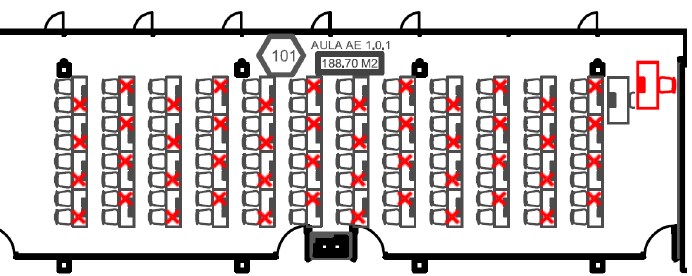
Figure 1. Room schema as an example of social distancing and reduced capacity (red X locations are not